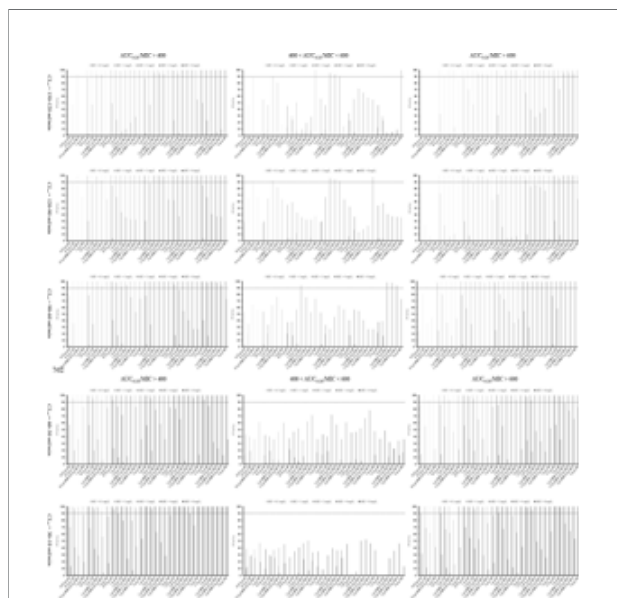
FIGURE 2 | PTA values of 34 dosage regimens for various MICs and CL cr at various AUC 0 – 24 /MIC targets. AUC 0 – 24 , daily area under the curve; MIC, minimum inhibitory concentration; AUC 0 – 24 /MIC, ratio of daily area under the curve to minimum inhibitory concentration; CL cr , creatinine clearance; LRRI, loading-rate rapid infusion in OTSI mode; LRCI, low-rate continuous infusion in OTSI